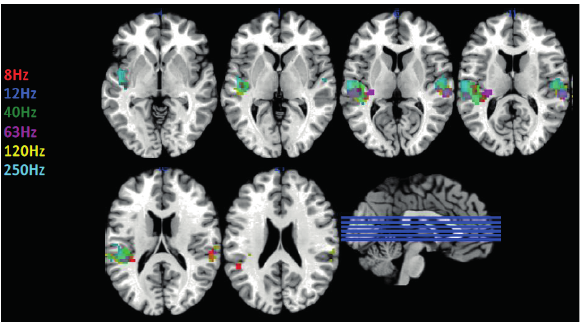
Fig. 2: Sample activation of auditory cortex during stimulation of the ear by low-frequency sound and infra-sound (courtesy of Chris- tian Kock, Physikalisch-Technische Bundesanstalt (PTB)). The brain activation at stimulus frequencies between 8 Hz and 250 Hz is de- tected by using fMRI images in various sectional planes through the